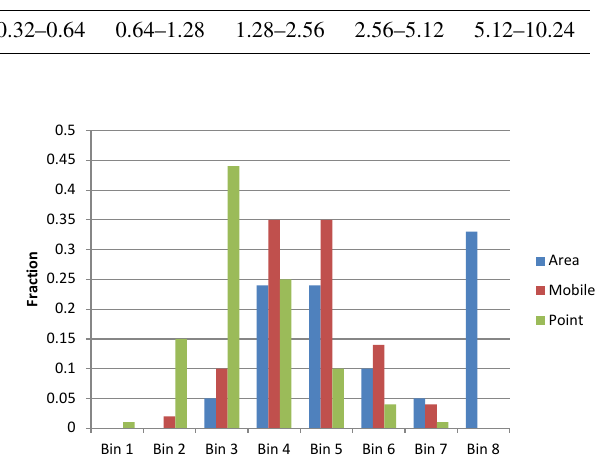
Table 3. PM 10 size-bin ranges as Stokes diameter (µm) for the 12-bin version of GEM-MACH. Bin 1